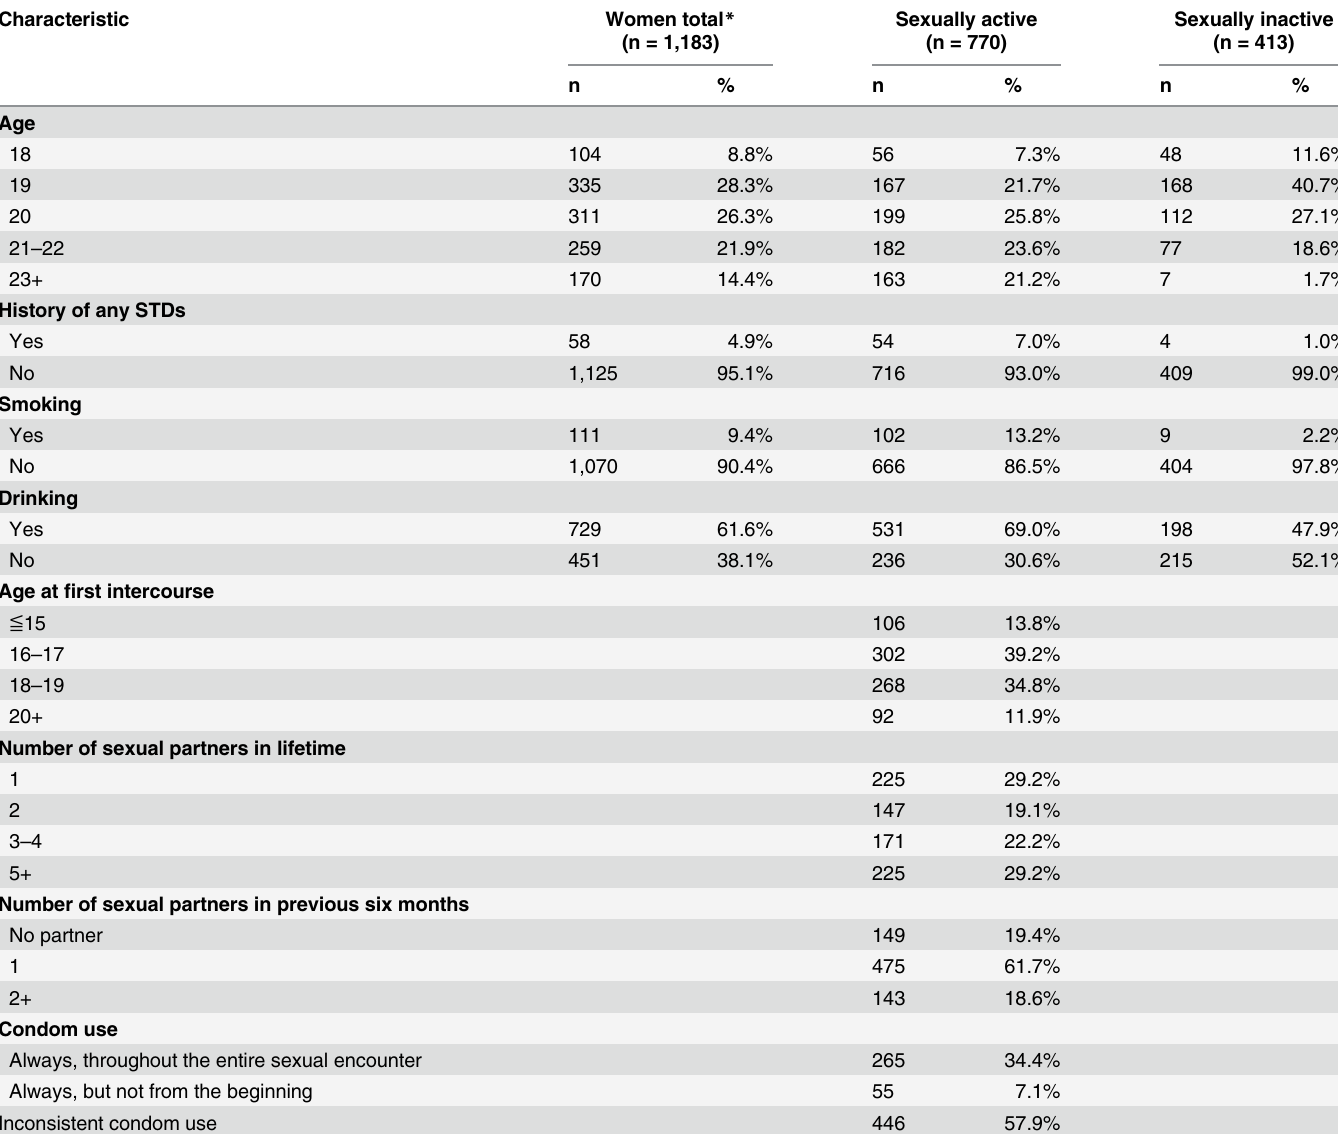
Table 1. General and sexual behavioral characteristics of